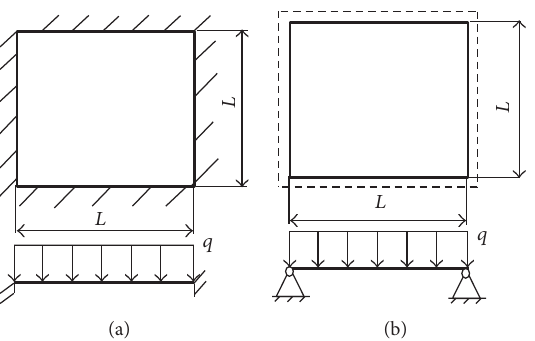
Figure 9: The Clamp and simply supported Mindlin plate under a uniform load: (a) clamp supported and (b) simply